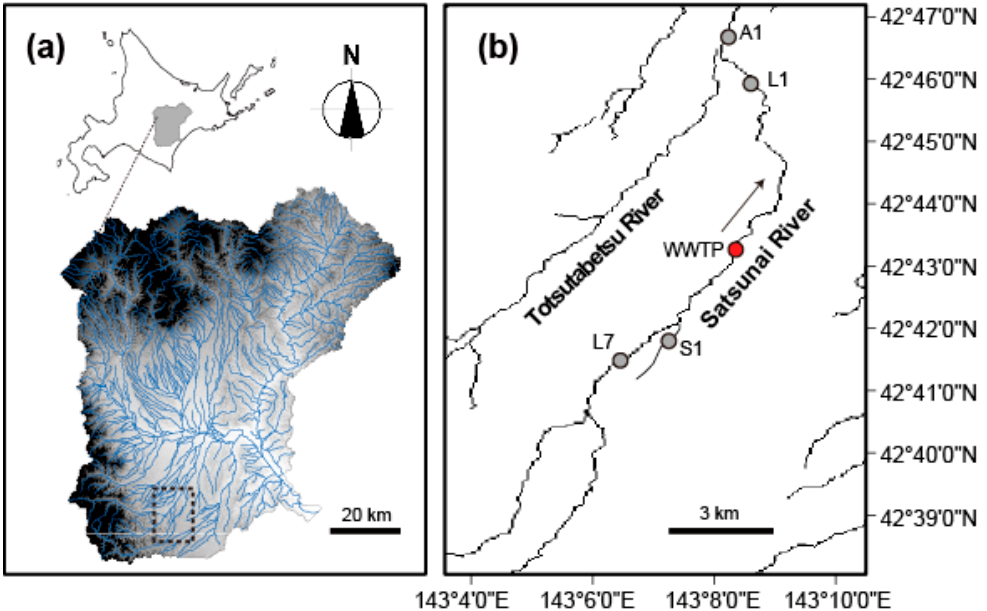
Figure 1. Location of the Tokachi watershed in Hokkaido, Japan where the study area is indicated by a dotted box ( a ) and four study sites (gray-filled circles) in the Satsunai River ( b ). A red-filled point indicates the confluence with a tributary affected by a wastewater treatment plant (WWTP). An arrow denotes the flow direction of the river.